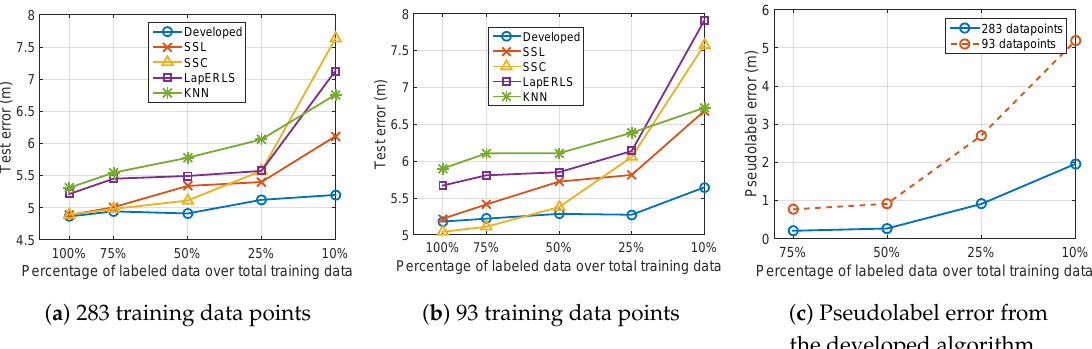
Figure 10. Localization results of the compared algorithms with respect to the variation of the ratio of the labeled training data over ( a ) total of 283 training data points and ( b ) total of 93 training data points. In ( c ), accuracy of the pseudolabels obtained from the developed algorithm is examined according to variation of the number of labeled